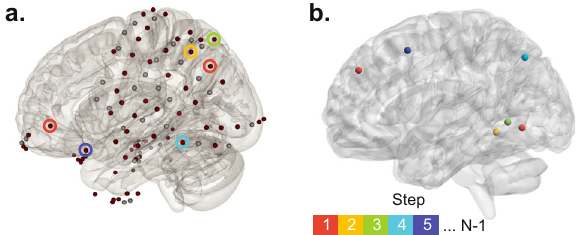
Fig. 5 Schematic of geometric structural connectivity null algorithm. a The brain overlay shows the position of all electrodes from a sample patient (#5). Selected electrodes are colored-coded (dark red). b We create geometric null by resampling the patient ’ s brain regions. At the fi rst step, we fi nd two random distant brain regions and fi nd a pair of empirically sampled brain regions such that the Euclidean distance between the empirical pair maximally matches that of the resampled null pair. The red circles in panel a highlight the empirically sampled electrodes and the center of corresponding null regions with red spheres. Next, out of all possible remaining 598 null regions of interest and the remaining N − 2 ( N = total number of selected electrodes) empirically sampled regions, we fi nd two brain regions, one from null and one empirical, with the most similar distances to the regions identi fi ed at the fi rst step. At each following step, we repeat this process until we resample N null regions. Here we illustrate this procedure by showing an example of matched empirical (color-coded circles in panel a ) and null (color-coded spheres in panel b ) regions over fi ve